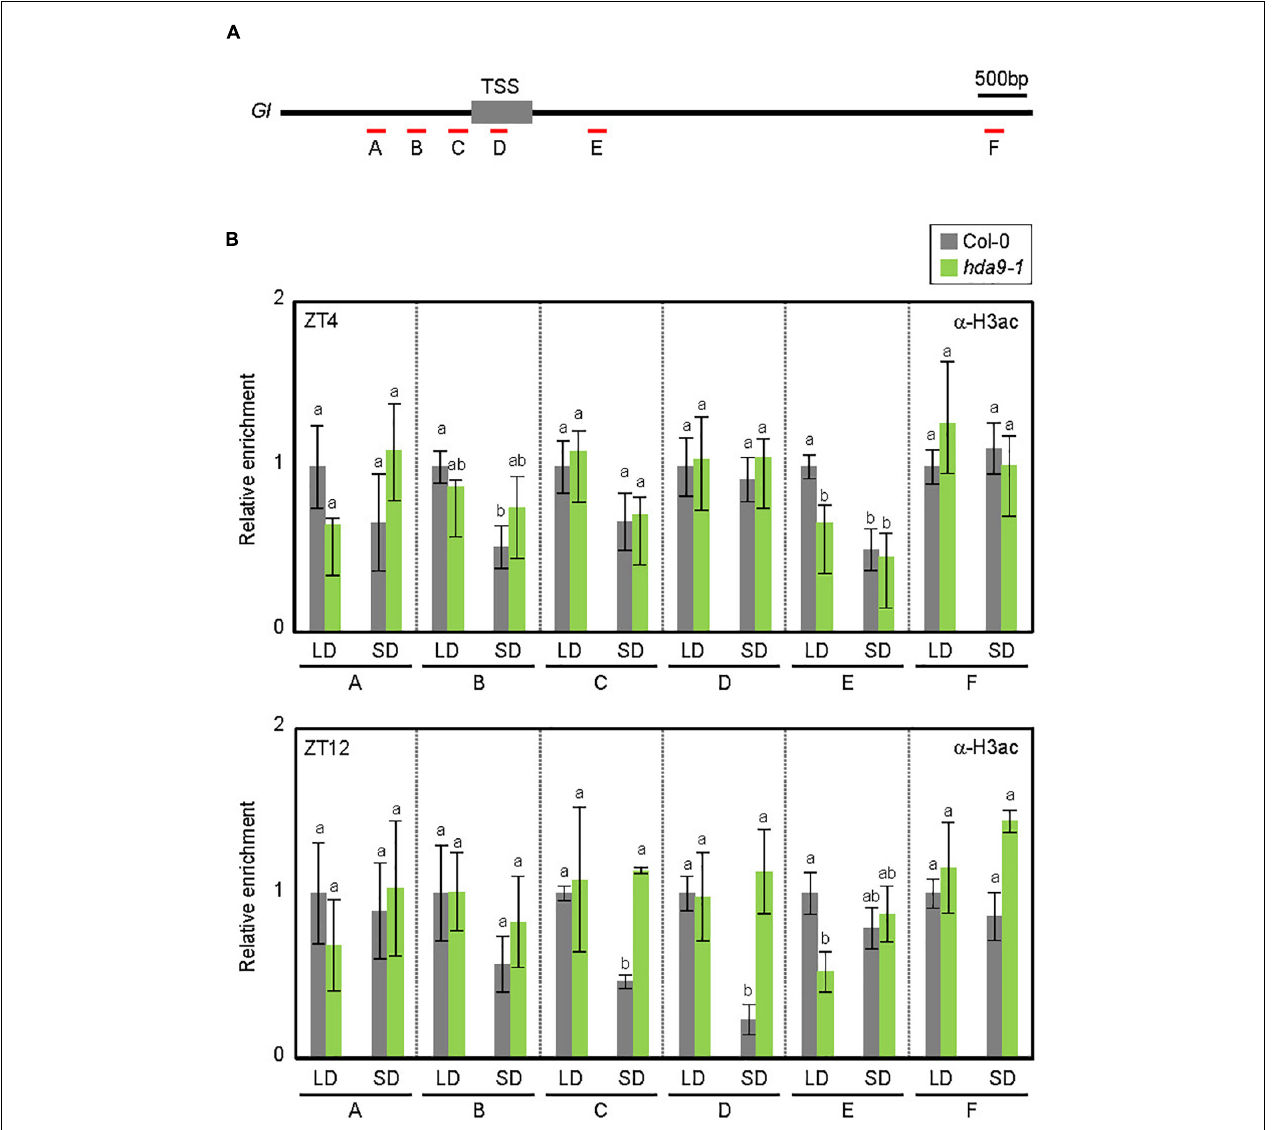
FIGURE 5 | HDA9 regulates histone H3 acetylation levels at the GIGANTEA ( GI ) locus. (A) Genomic structure of GI . Underbars indicate the regions amplified by PCR following chromatin immunoprecipitation (ChIP). (B) HDA9 mediates the histone deacetylation at the GI locus in SDs. Seven-day-old seedlings grown under long day (LD) and short day (SD)conditions were harvested at ZT4 and ZT12, and subjected to the ChIP using anti-H3ac antibody. Three biological replicates were averaged. Error bars indicate the standard error of mean (SEM). Different letters represent a significant difference at P < 0.05 (one-way ANOVA with Fisher’s post hoc test).